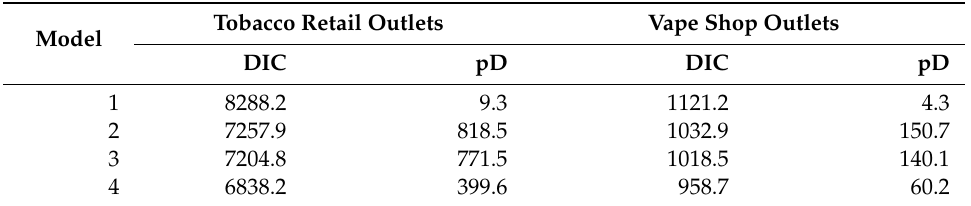
Table 1. Deviance information criterion (DIC) and e ff ective number of parameters (pD) values for models explaining tobacco retail outlet and vape shop outlet rates in Virginia,